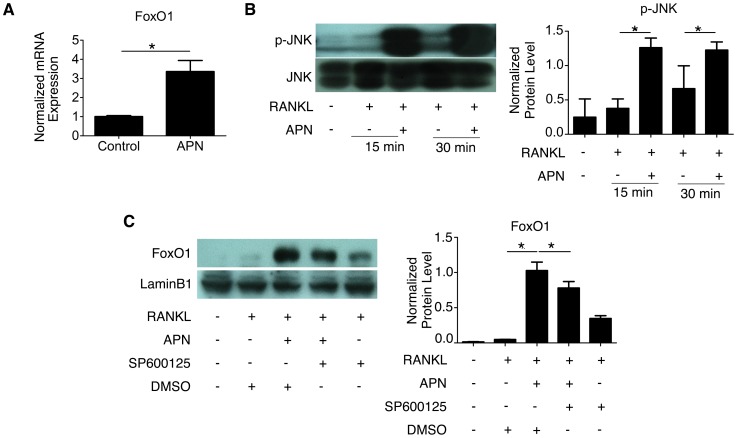
APN Induces FoxO1 and JNK Phosphorylation in RANKL-Treated RAW264.7 Cells.(A) qRT-PCR of FoxO1 mRNA levels in RAW264.7 cells treated with 50 ng/ml RANKL in the absence (control) and presence of 0.5 µg/ml APN treatment for 24 hours. The mRNA level was normalized with those of GAPDH. (B) Western blot for phosphorylated JNK in RAW264.7 cells treated with 50 ng/ml RANKL in the absence or presence of 0.5 µg/ml APN for 15 or 30 minutes. JNK was detected as the loading control. Data are shown as mean ± SD of three independent experiments. *P<0.05. (C) Western blot of FoxO1 nuclear protein extracted from RAW264.7 cells that were treated with 50 ng/ml RANKL in the presence and absence of 0.5 µg/ml APN, with or without prior treatment with the JNK inhibitor SP600125 for 2 hours. DMSO was used to dissolve SP600125. Nuclear Lamin B1 was used as the loading control. Data are shown as mean ± SD of three independent experiments. *P<0.05.